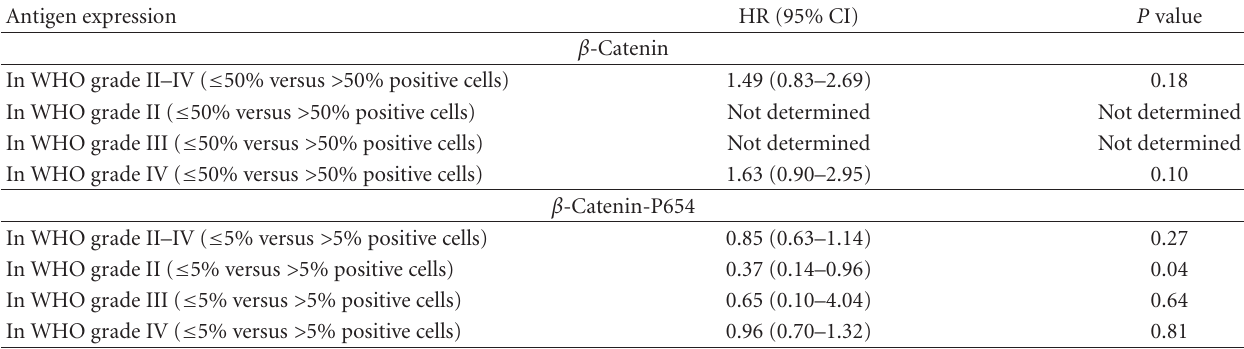
Table 3: Results from multivariate survival analysis. Hazard ratios were adjusted for WHO grade, age at diagnosis, and extent of tumour